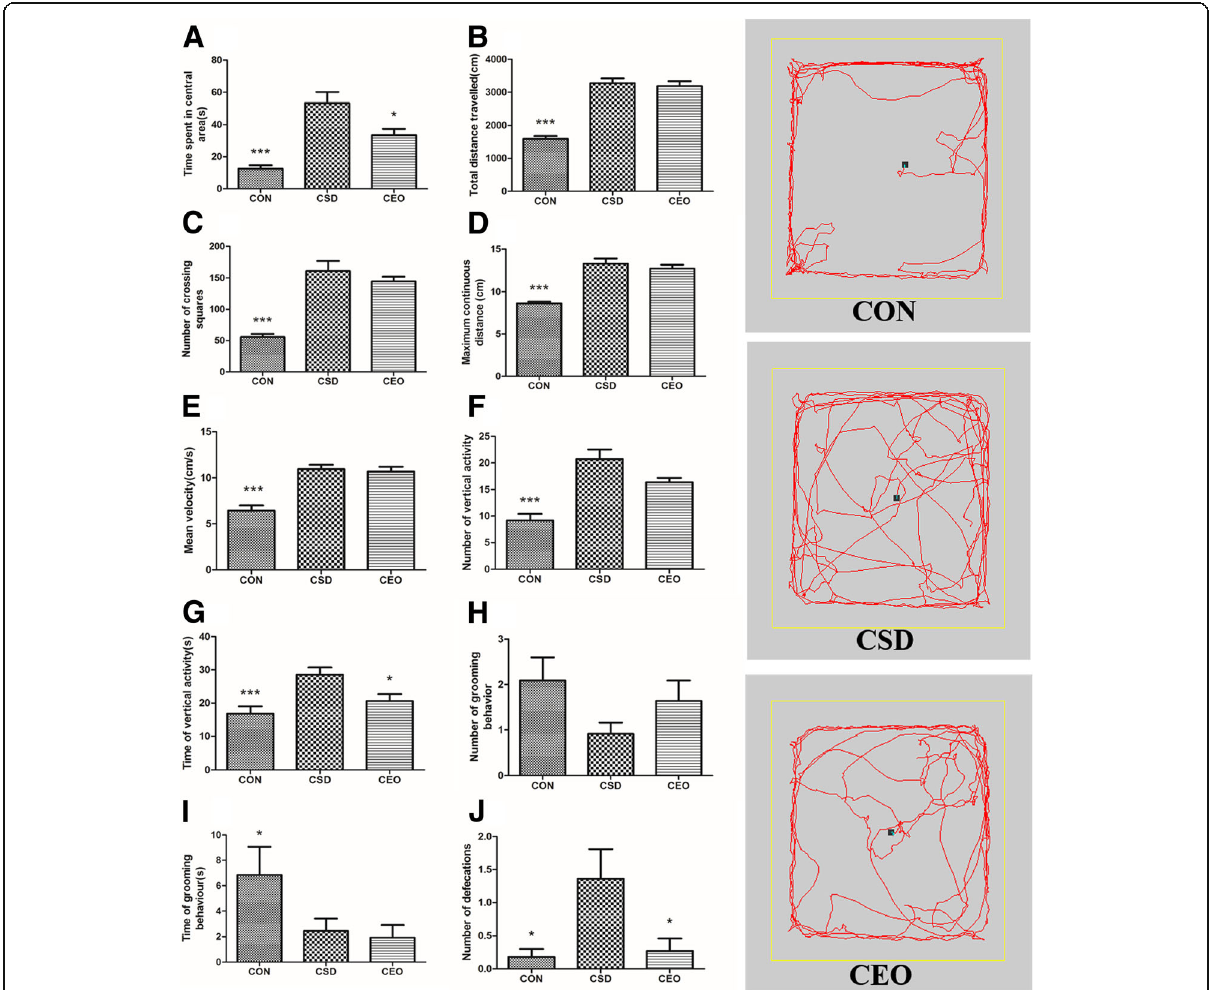
Fig. 4 Assessment of open field test. All indexes were recorded in a test of 5 min. All data were represented as the mean ± SEM ( n = 11), * refers to p < 0.05, *** refers to p < 0.000 vs. CSD group. The time spent in center of CON group was significantly shorter compared with CSD group, and CEO decreased the central time ( a ). The total distance travelled ( b ), number of crossing squares ( c ), max continuous distance ( d ), mean velocity ( e ) of CON group all decreased significantly compared with CSD group respectively, and treatment of CEO showed a reduction trend on these parameters. Number and time recorded of vertical activity ( f , g ) showed the same situation as horizontal activity. No significant difference was found in the number of grooming behavior ( h ). The time of grooming ( i ) in CON group were significantly higher than CSD group. Number of defecations ( j ) of CSD group increased significantly compared with CON group, and CEO was seen to decrease the measure